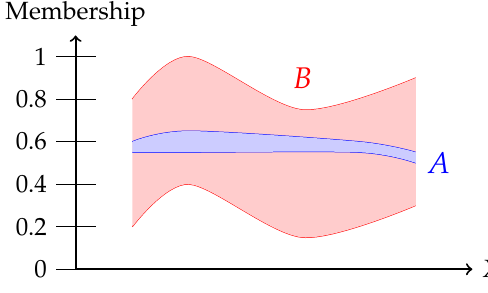
Figure 4. A is embedded in B .